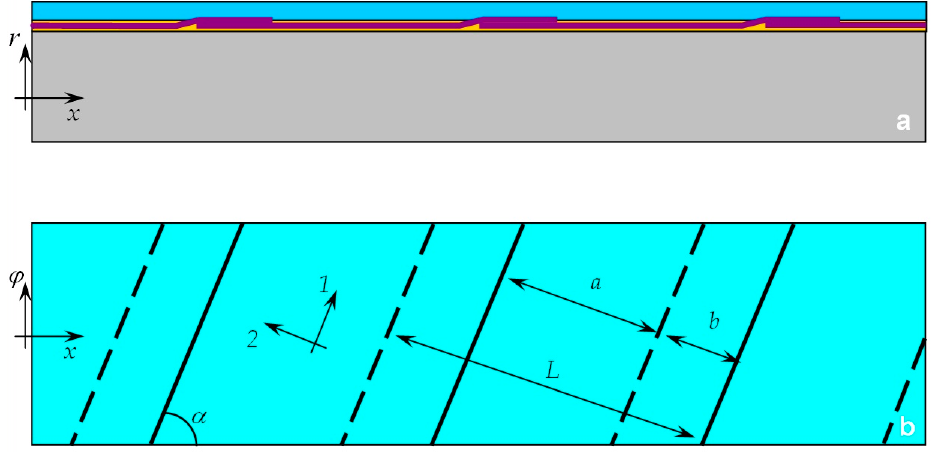
Figure 2. Diagram of a pipe with spiral-wound composite coating: ( a ) longitudinal section of the wall of the pipe with the composite coating; ( b ) scheme of laying strips of fiberglass.